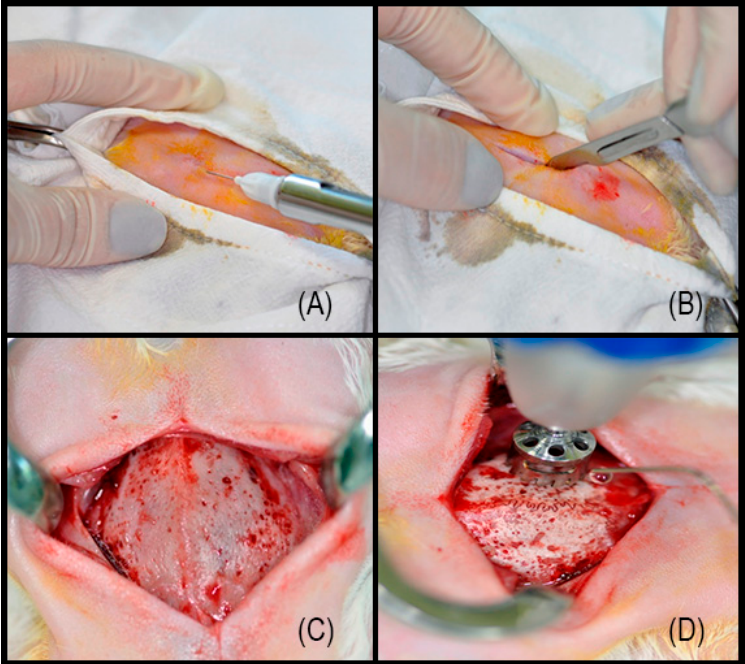
Figure 2. ( A ) Local anesthetic; ( B ) Linear incision, 5 cm long; ( C ) Parietal bone exposed; ( D ) Trephine bur with 8 mm diameter used to create the defect.